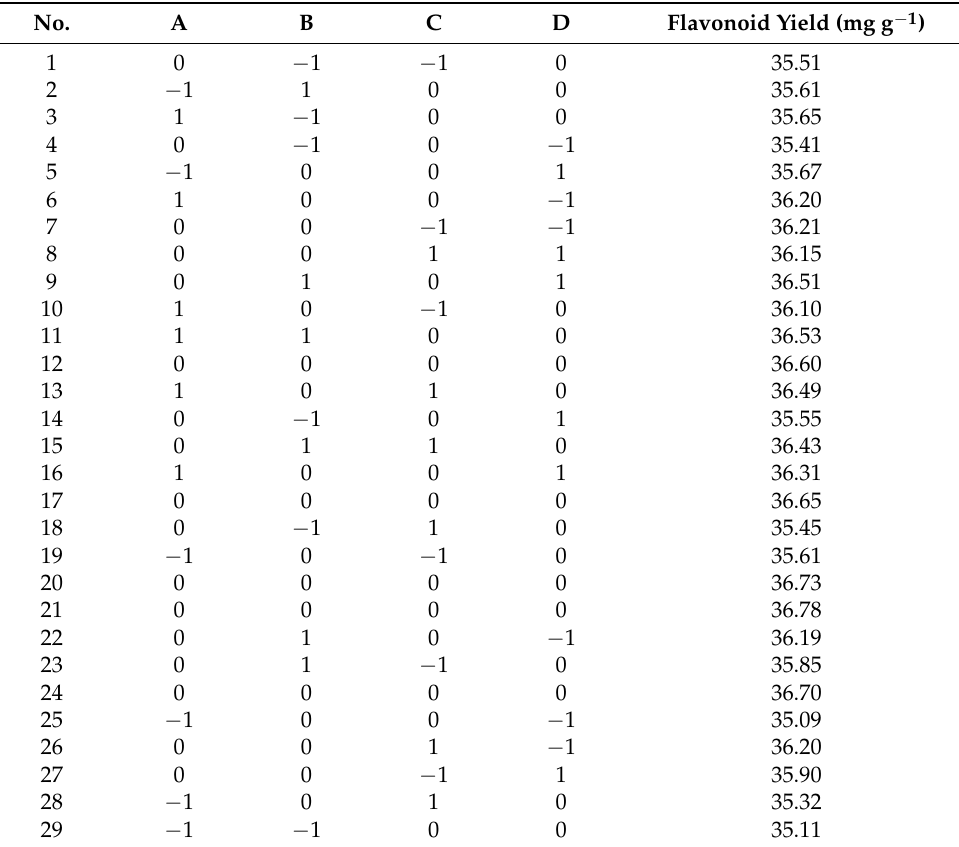
Table 2. Design and results for the response surface experiment.